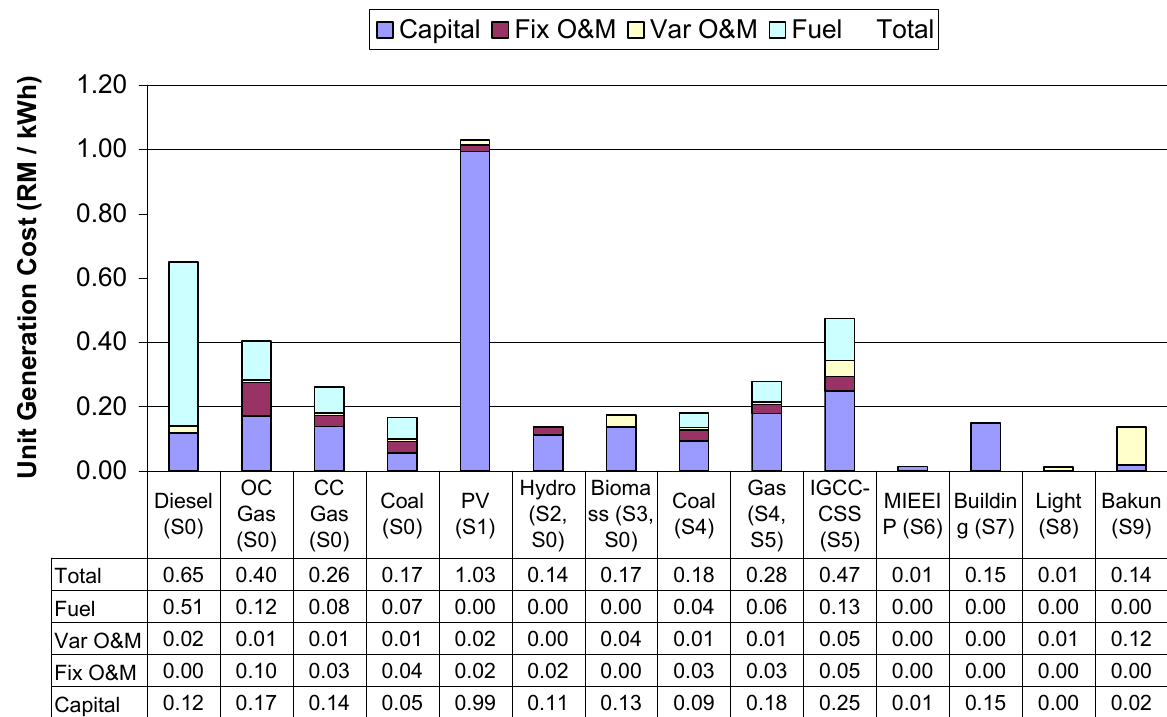
Figure 8. Average unit cost of power generation for all